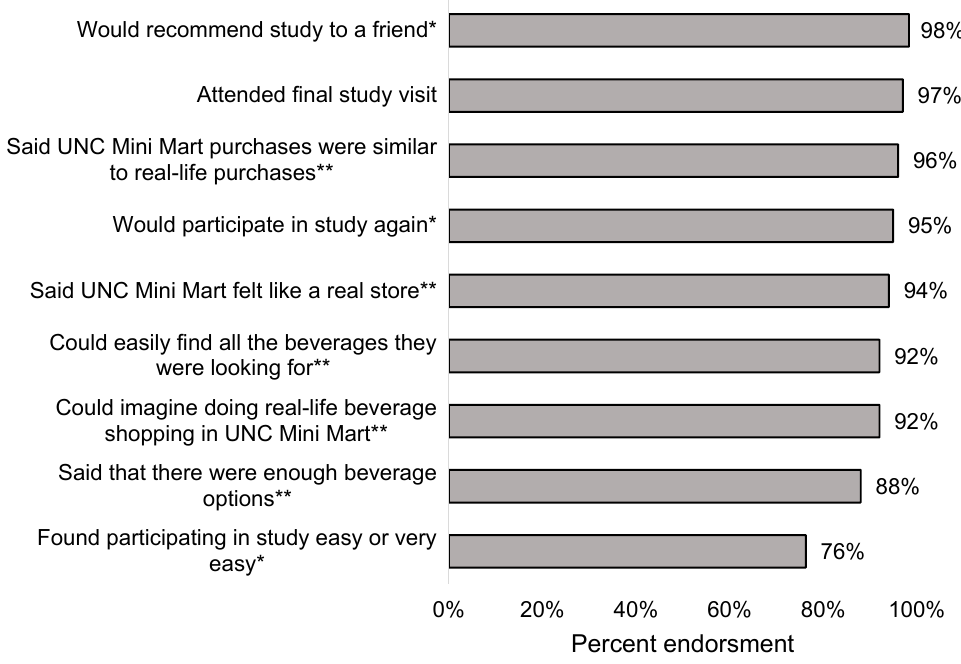
Figure 3. Realism of UNC Mini Mart and acceptability of participating in a study among Latinx parents ( n = 61). * Responses collected via computer survey at Visit 5. ** Responses collected over the phone due to survey error.